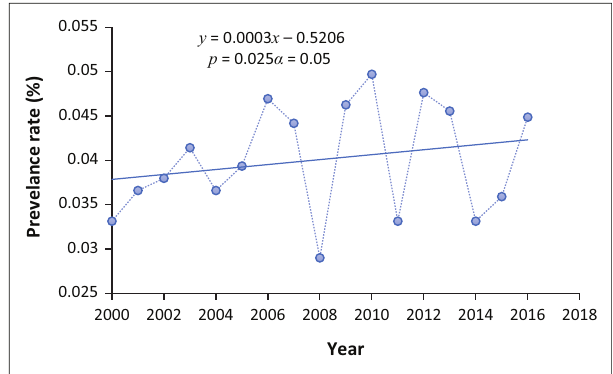
FIGURE 6: Malaria trends in Masvingo